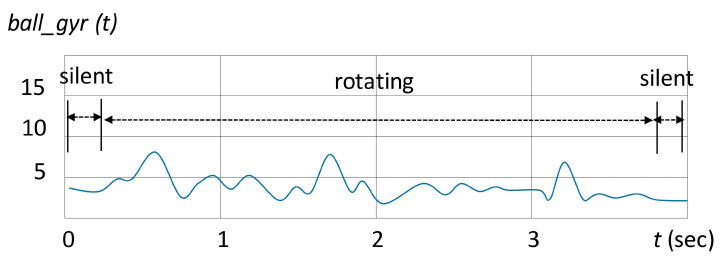
Figure 6. Illustration of the signal from ball_gyr during the straight-line dribbling. The total rotation angle of the ball can be obtained by accumulating the sensor signal during the rotating